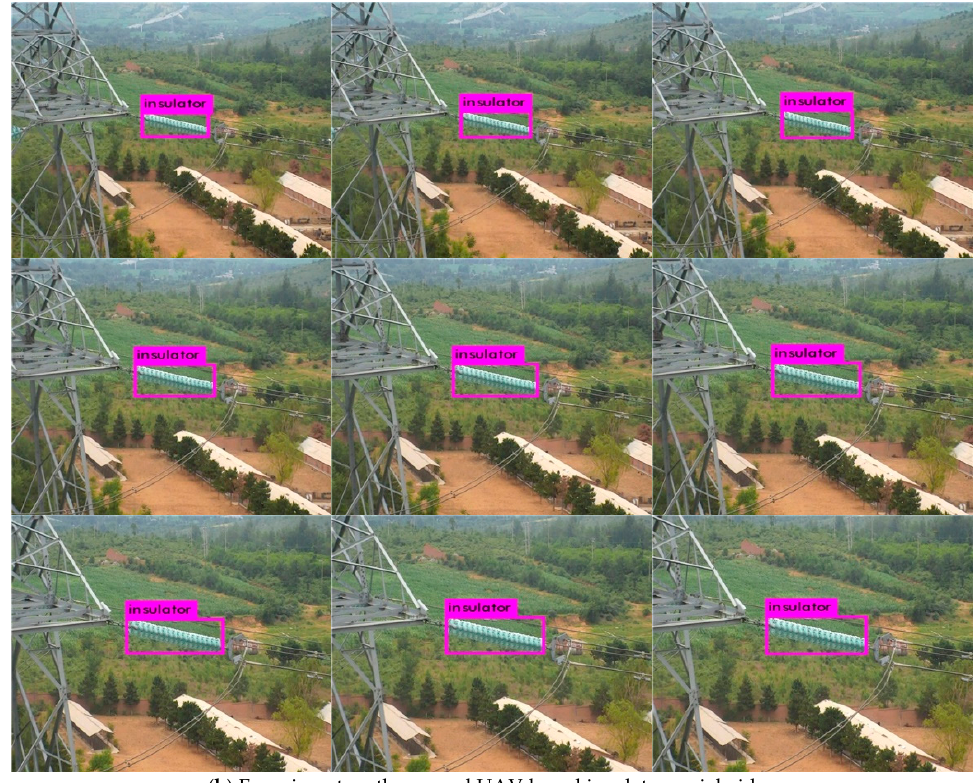
Figure 7. Experiments on two UAV-based insulator aerial videos. In ( a , b ), the performances of the proposed method in consecutive 9 frames are shown in order from left to right and top to bottom.